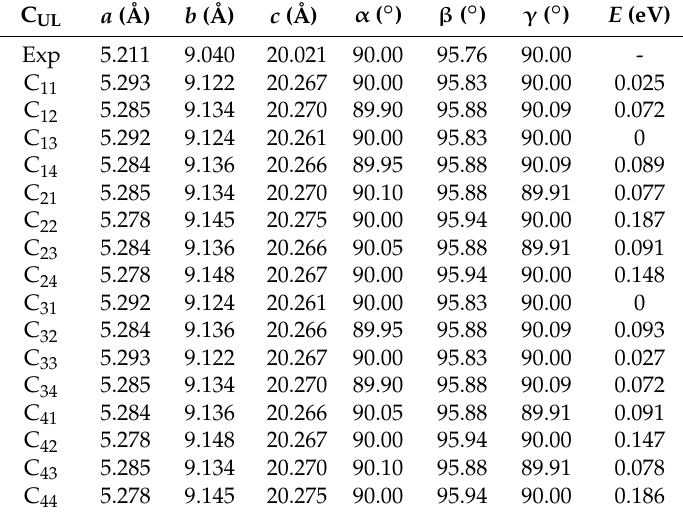
Table 1. The calculated crystallographic parameters of sixteen